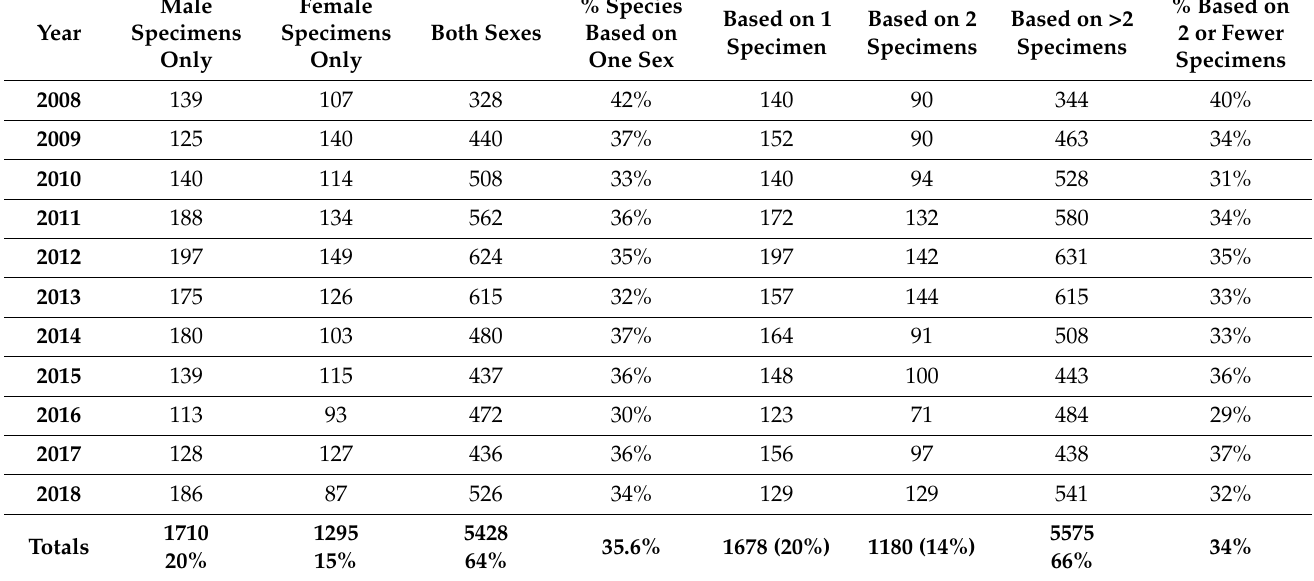
Table 4. The 2008–2018 summary data showing numbers of species for which males and females were described and the number of specimens associated with each new species description. Percentages (of Totals) are the percentage of each column relative to the total number of species evaluated during the project time